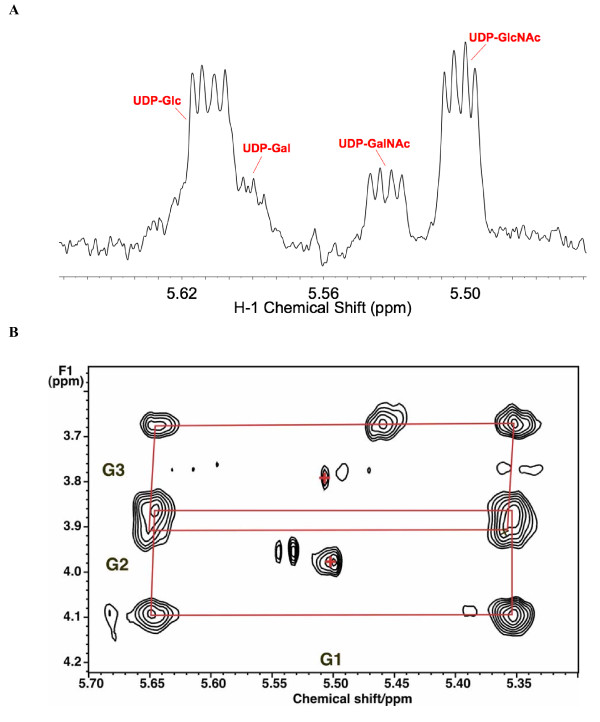
NMR identification of UDP-hexoses. LN3 cells were grown in unlabeled glucose and extracted as described in the Methods section. One-dimensional 1H NMR spectra were recorded at 20°C, 800 MHz. Two-dimensional 1H total correlation spectroscopy (TOCSY) spectra were recorded at 600 MHz using a mixing time of 50 ms with a spin lock field strength of 8 kHz. (a) One-dimensional NMR spectrum. The sugar anomeric region shows several resonances that are double doublets, that is, a single proton scalar coupled to two different spin 1/2 nuclei. By comparison with standard spectra, these have been assigned to the glucose H1 of UDP-glucose, UDP-galactose (UDP-Gal), UDP-GalNAc and UDP-GlcNAc by 1H and 13C chemical shifts, splitting patterns, 13C labeling and two-dimensional TOCSY crosspeak patterns as described in the text. (b) Anomeric region of example TOCSY spectrum showing 13C satellites of glucose H1-H3 of UDP-GlcNAc due to incorporation of [U-13C]-glucose. The satellite crosspeaks (denoted by red rectangles) represent the covalent linkages of H1 to H2 and H3 of the glucose moiety (labeled respectively as G1, G2 and G3), which were essentially completely labeled at 48 h. Crosses denote the crosspeaks of protons attached to 12C.